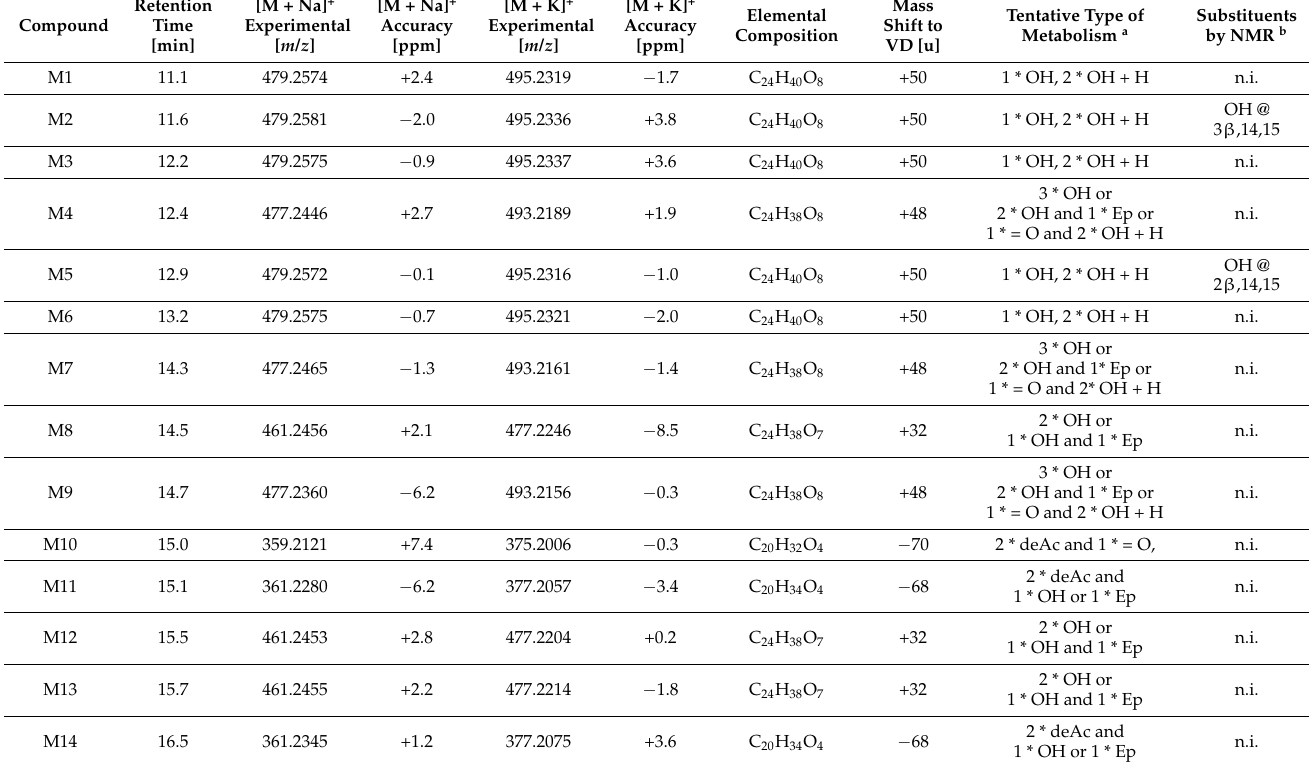
Table 1. Tentative or HPLC-SPE-NMR-confirmed metabolites of vitetrifolin D (VD) formed in HLM (M1–M22), and additionally in S9 (SM1–SM5), cells. Analytes are sorted according to their retention times in the HPLC-DAD-QTOF- MS